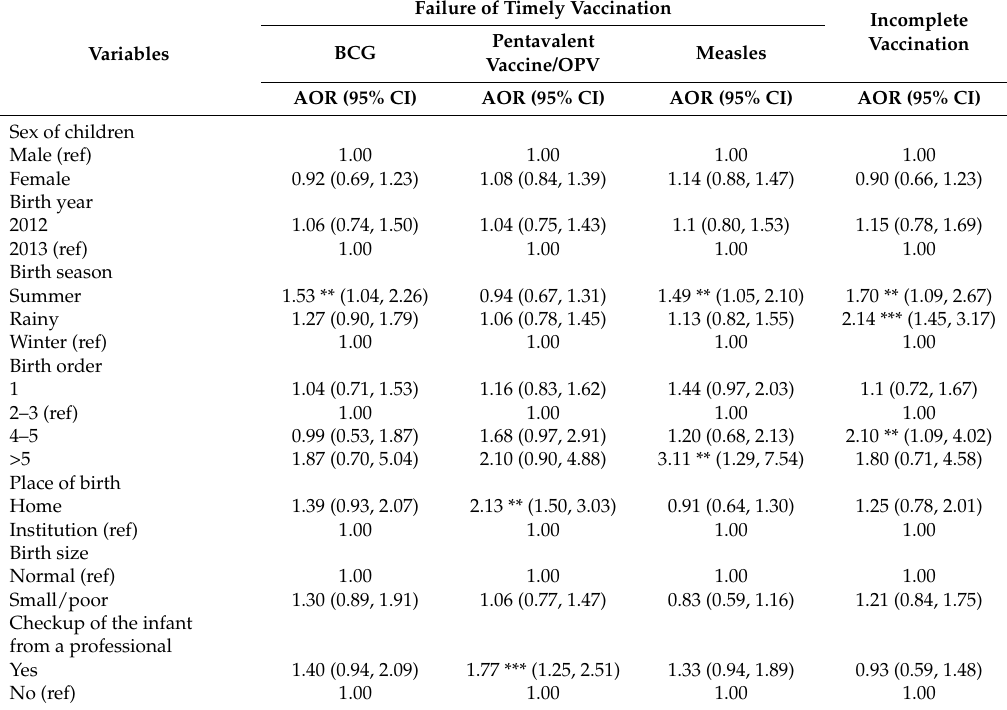
Failure of Timely Vaccination